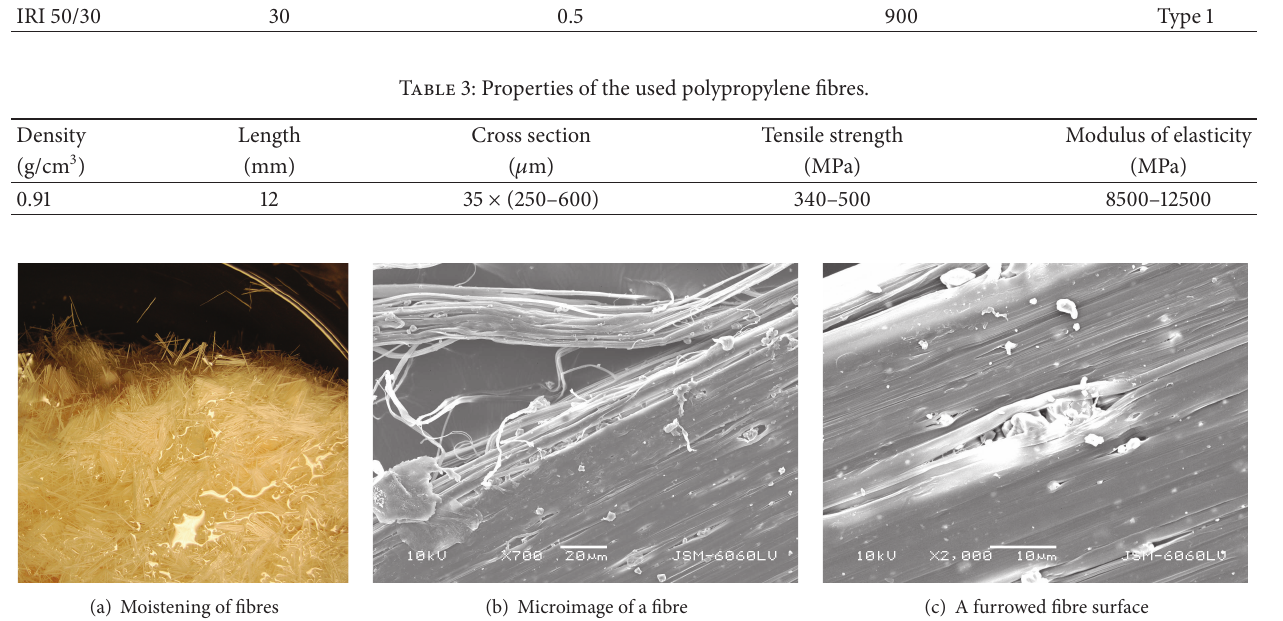
Figure 2: The polypropylene fibres which were added to some other concrete